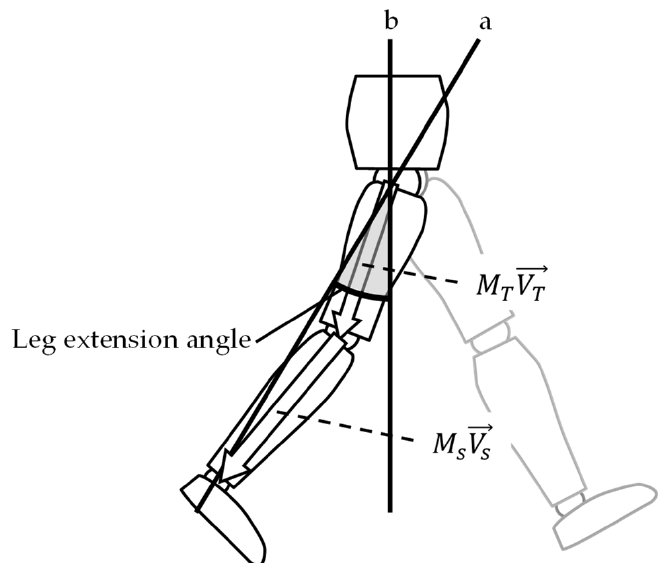
Figure 2. Estimation of the leg extension angle. Leg extension angle was calculated as an angle consisting of a line connecting the hip joint with the ankle joint ( a ), and the laboratory’s vertical axis ( b ) at late stance in the sagittal plane. M T , tilt angle matrix of thigh segment; M s , tilt angle matrix of the shank segment; V T , vector of the thigh segment; V s , vector of the shank segment.